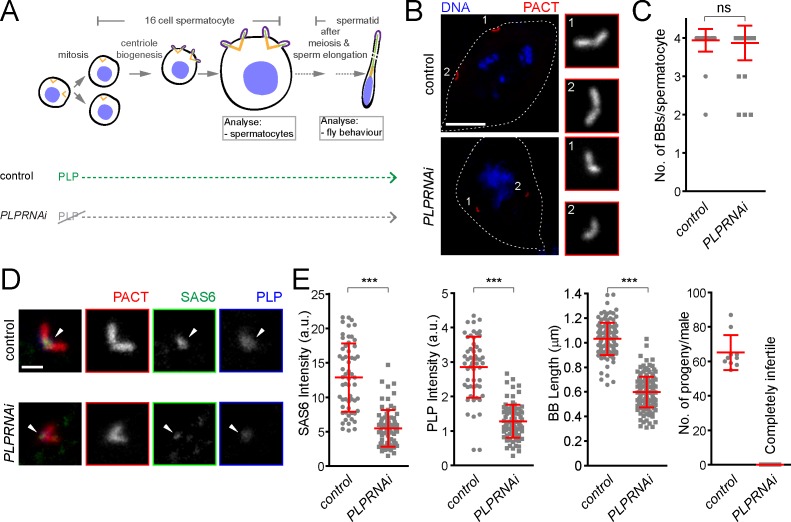
Drosophila pericentrin (PLP) is required for SAS-6 recruitment to the sperm centriole/basal body and for its elongation.(A) Schematic illustration of the experiments to deplete PLP during centriole biogenesis and elongation. (B) Representative images of mature spermatocytes in flies with different genotypes. PACT (red) is a commonly used marker for basal bodies (BB) and DAPI (blue) stains DNA. Insets show RFP::PACT close to the numbers (in gray scale). (C) Quantification of the number of BBs per cell in mature spermatocytes. (D) Representative images of mature spermatocyte BB in flies with different genotypes. RFP::PACT (red) marks BBs, Anti-SAS-6 (green) and Anti-PLP (blue) antibodies stain the proximal part of BB (arrowheads). (E) Quantification of SAS-6, PLP, BB length and the number of progeny in flies with different genotypes. We repeated all experiments three times. For SAS-6 and PLP intensities and BB length analysis, the number of BBs quantified for each genotype is N ≥ 108 (54 pairs of BBs) and N ≥ 128, respectively. The total number of males used for each histogram bar is N ≥ 10. Notably, given that moderate overexpression of PACT domain (using polyUbiquitin promoter) in the plp mutant fly fails to rescue the observed centriole as well as behavior defects of the mutant (Martinez-Campos et al., 2004), we used RFP::PACT to study the sperm basal bodies in the knockdown experiments. Scale bars in (B) and (D) represent 10 and 1 µm, respectively. Means ± s.d are shown in red (ns-not significant, ***p<0.001, Mann-Whitney U test).10.7554/eLife.41418.026Figure 7—source data 1.The source data to plot the graph in Figure 7C and E.